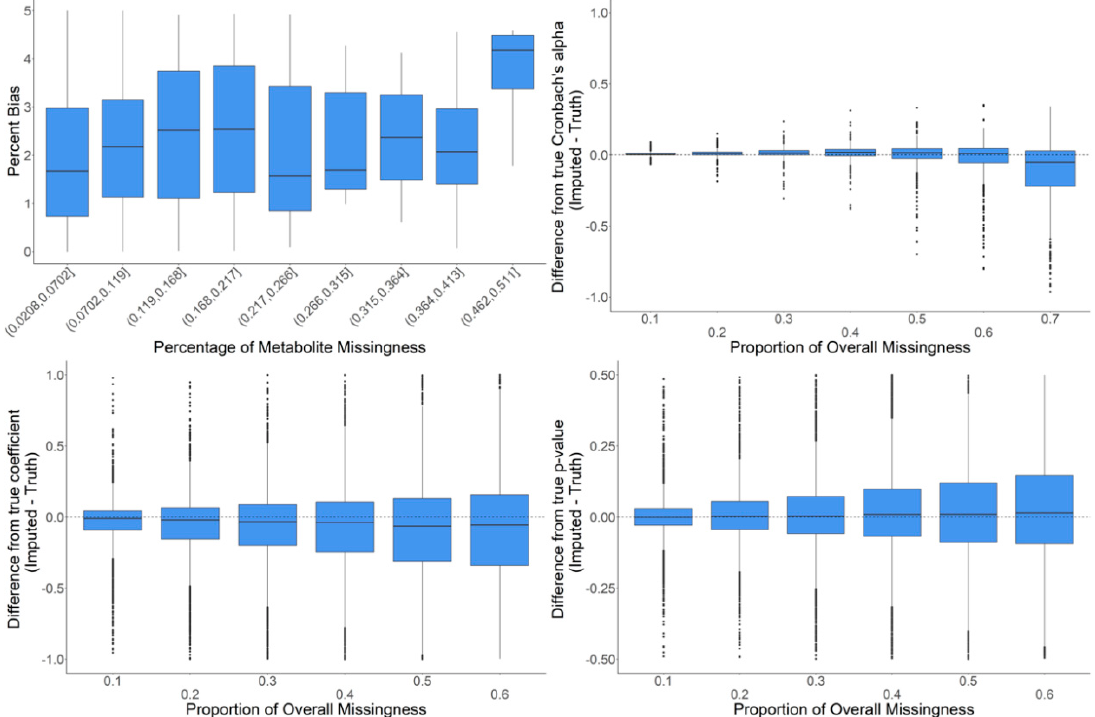
Figure 8. In-depth evaluation of RF imputation. Percent bias (accuracy of imputation on raw data) is shown in the upper left for metabolites in bins of percent missingness between 2–51%. Differences in Cronbach’s alpha are shown in the upper left for a variety of proportions of overall missingness between 10–70%. The differences in regression coefficients are shown in the bottom left for a variety of proportions of overall missingness between 10–60%. The respective differences in p -values are shown in the bottom right. The center line represents the median. The lower and upper box limits represent the 25% and 75% quantiles, respectively. Black dots represent single iterations of evaluating differences that are outliers. The whiskers extend to the largest observation within the box limit ± 1.5 × interquartile range.